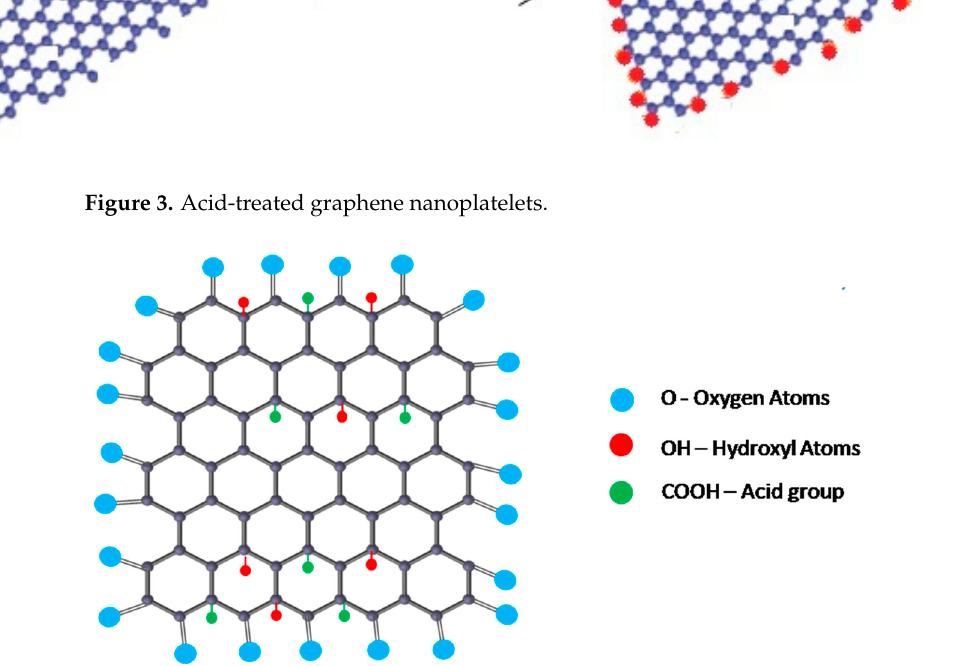
Figure 4. Structure of functionalized graphene.